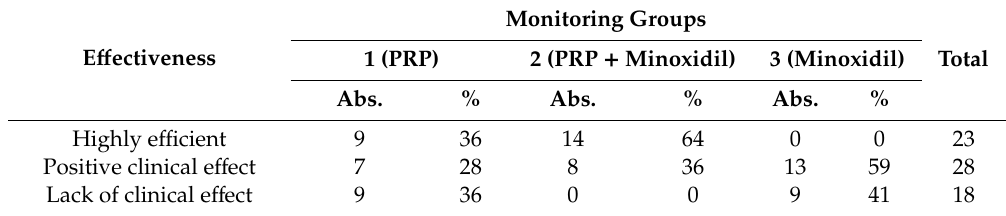
Table 6. Assessment of clinical e ffi